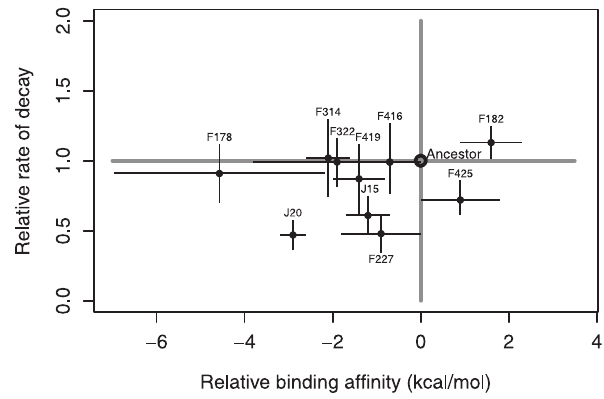
Figure 5. Plot of relative binding affinity ( DD G) against relative decay rate for high-temperature mutations. Increased stability is associated with relative binding affinities less than zero and decay rates less than one. Error bars show the 95% confidence interval obtained by performing multiple independent experiments and simulations. Most data points lie in the lower left quadrant or on its boundary